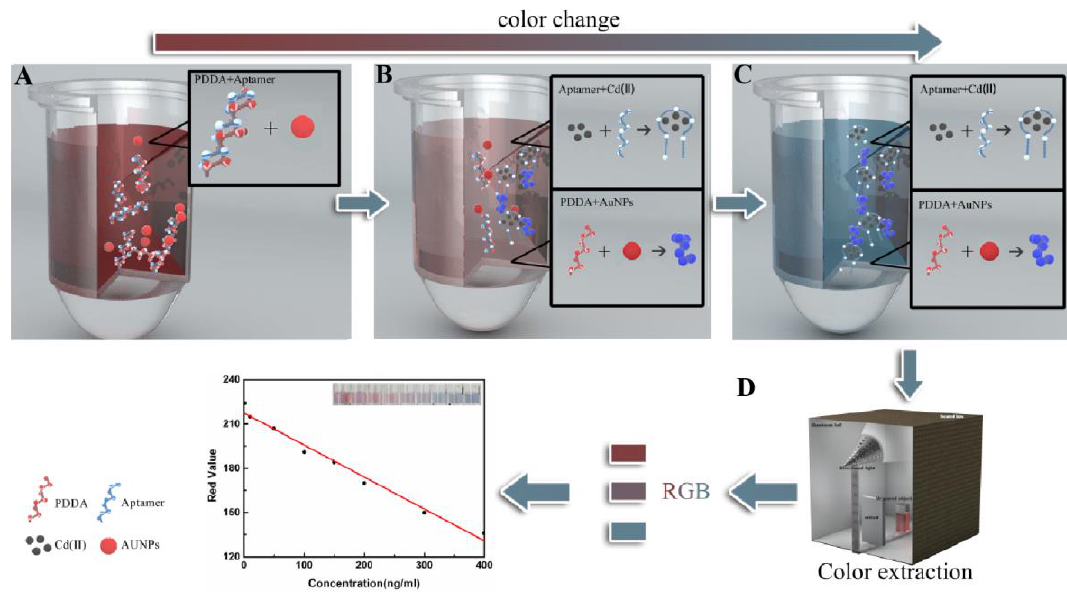
Figure 1. Schematic illustration of the colorimetric method. ( A ) Gold nanoparticles (AuNPs) incubated with aptamer and polydiene dimethyl ammonium chloride (PDDA); the color of the free AuNP solution was wine red; ( B ) AuNPs incubated with the aptamer, PDDA, and few Cd(II); the color of partial aggregation of the AuNP solution changed to reddish; ( C ) AuNPs incubated with the aptamer, PDDA, and sufficient Cd(II); the color of aggregation of the AuNP solution changed to blue; and ( D ) The red(R) values of the solution recorded with a smart phone.